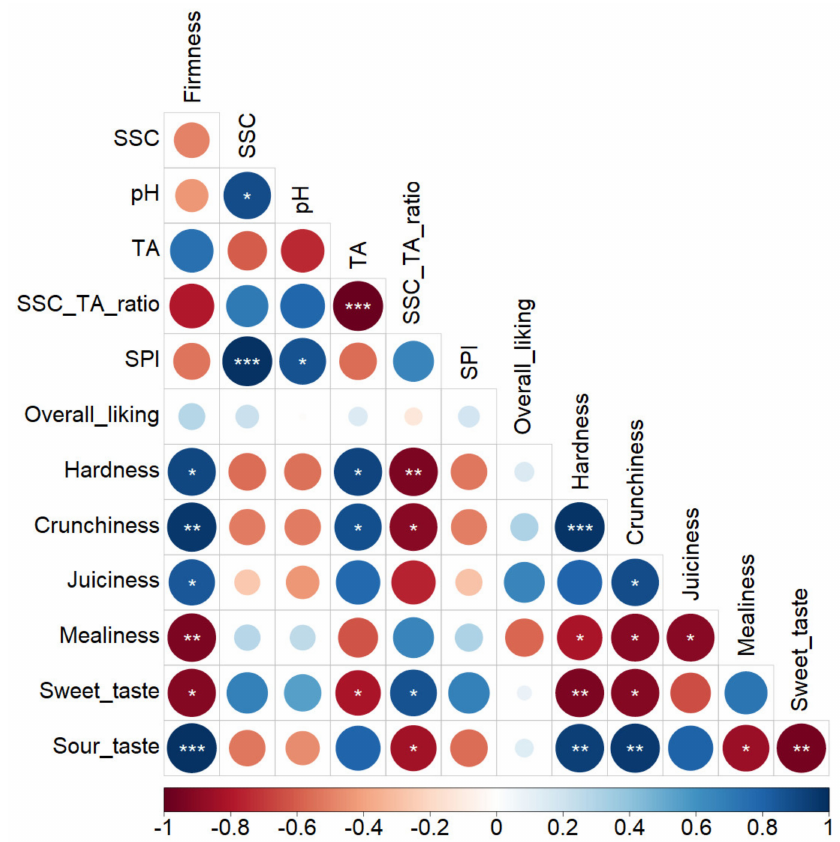
Figure 4. Correlogram representing the Pearson correlation coefficient matrix between apple compo- sition and sensorial attributes. Asterisks indicate the significance of the Pearson correlation coefficient (*, **, *** correspond to p ≤ 0.05, 0.01 and 0.001, respectively). Colors indicate different values of the correlation coefficient according to the scale bar reported at the bottom. The size of the circle is proportional to the correlation